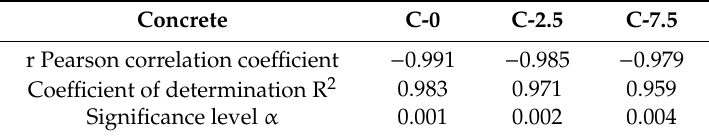
Table 11. Specification of relations between variables temperature—average strength.